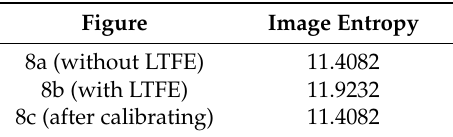
Table 10. Image contrast of Figure 8. Figure Image Contrast 8a (without